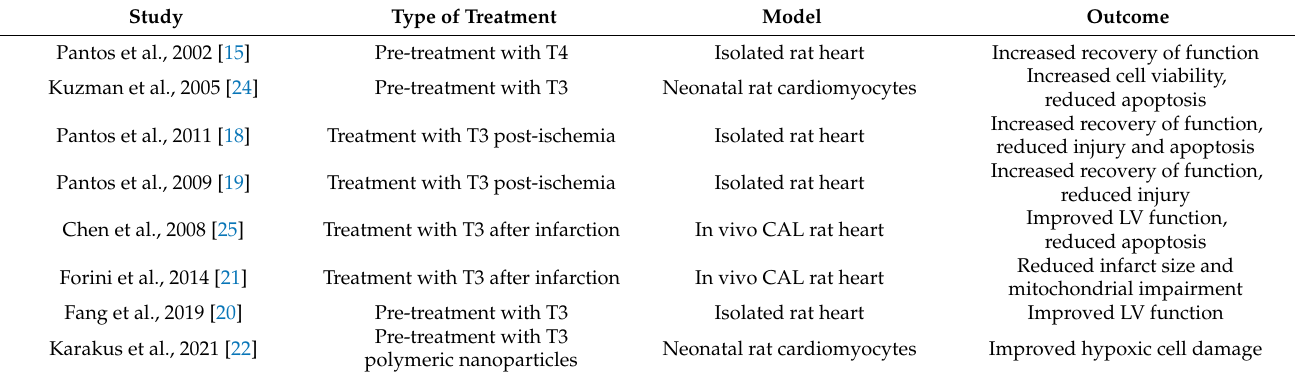
Table 1. Accumulating experimental evidence shows that thyroid hormone plays a critical role in protection/adaptation of the heart to hypoxic/ischemic injury. CAL = Coronary Artery